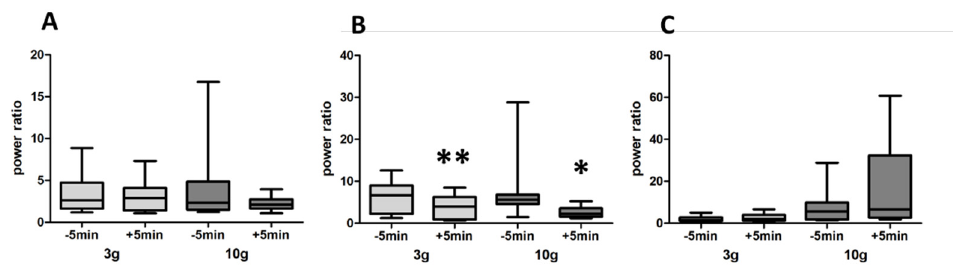
Figure 8. ( A ). Intravenously injected NaCl had no effect on the beta-band power elicited by 3 g or 10 g food pellet odour. Olfactory stimulations were performed 5 min before and 5 min after injection ( n = 9 rats). ( B ). Simultaneous administration of the dopaminergic antagonists D1 (SCH23390) + D2 (raclopride) (i.v.) elicited a significant decrease of beta frequency activity to food odour for both 3 g and 10 g ( n = 8 rats). Olfactory stimulations were performed 5 min before and 5 min after injection. ( C ). Intravenous administration of the dopaminergic agonists D1 (A68930) + D2 (quinpirole) (i.v.) had no effect on LFP increase to 3 g and to 10 g food odour ( n = 8 rats). Olfactory stimulations were performed 5 min before and 5 min after injection. * p < 0.05; ** p < 0.01. Likewise, neither a combination of the D1 agonist A68930 + D2 antagonist raclopride (Figure 9A) nor the combination of D1 antagonist SCH23390 + D2 agonist quinpirole (Figure 9B) had any effect on the LFP increase elicited by 3 g (respectively p = 0.5469 and p = 0.0781) and by 10 g (respectively p = 0.3828 and p = 0.6406) food odour.